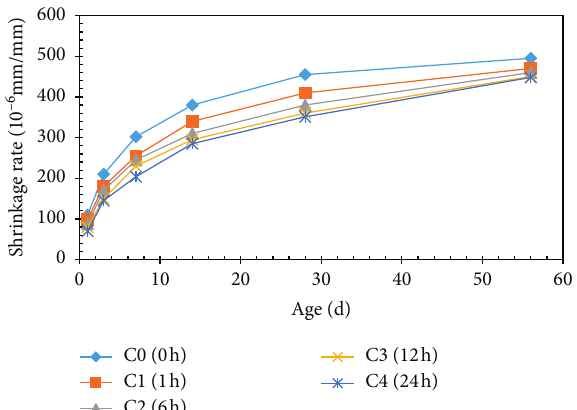
Figure 5: Effect of prewetting time on shrinkage rate for different CGC prewetting times.